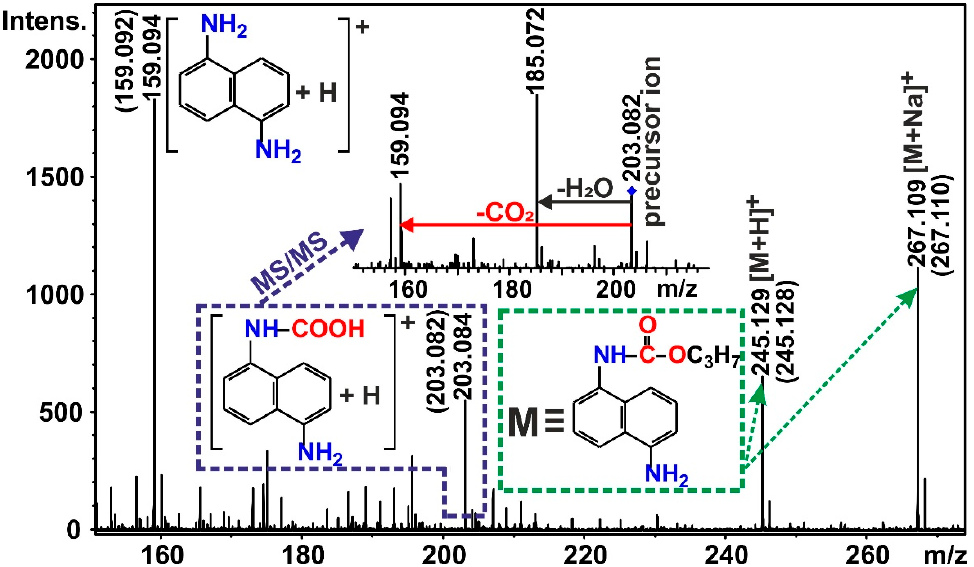
Figure 4. ESI-MS spectrum of the reaction mixture obtained in the reaction of 1,5-ICAN with the mixture of water/ i PrOH and HgCl 2 . The numbers in brackets are the calculated m/z values. The inset shows the MS/MS spectrum of the protonated (5-aminonaphthalen-1-yl)carbamic acid at m/z 203. As indicated in Figure 4, the ESI-MS spectrum reveals the presence of the protonated